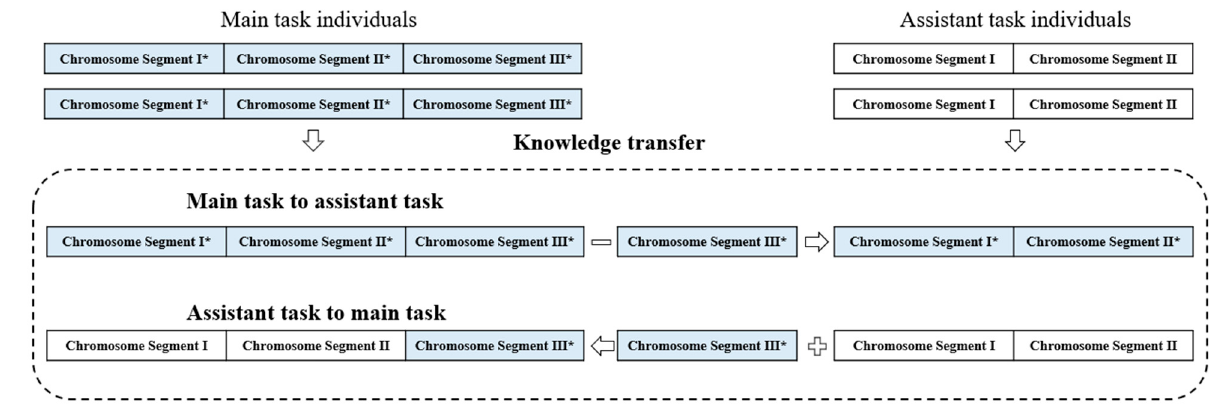
Figure 7. The transfer process of multi-task optimization. The symbol “*” denotes the chromosome segment comes from a main task individual.